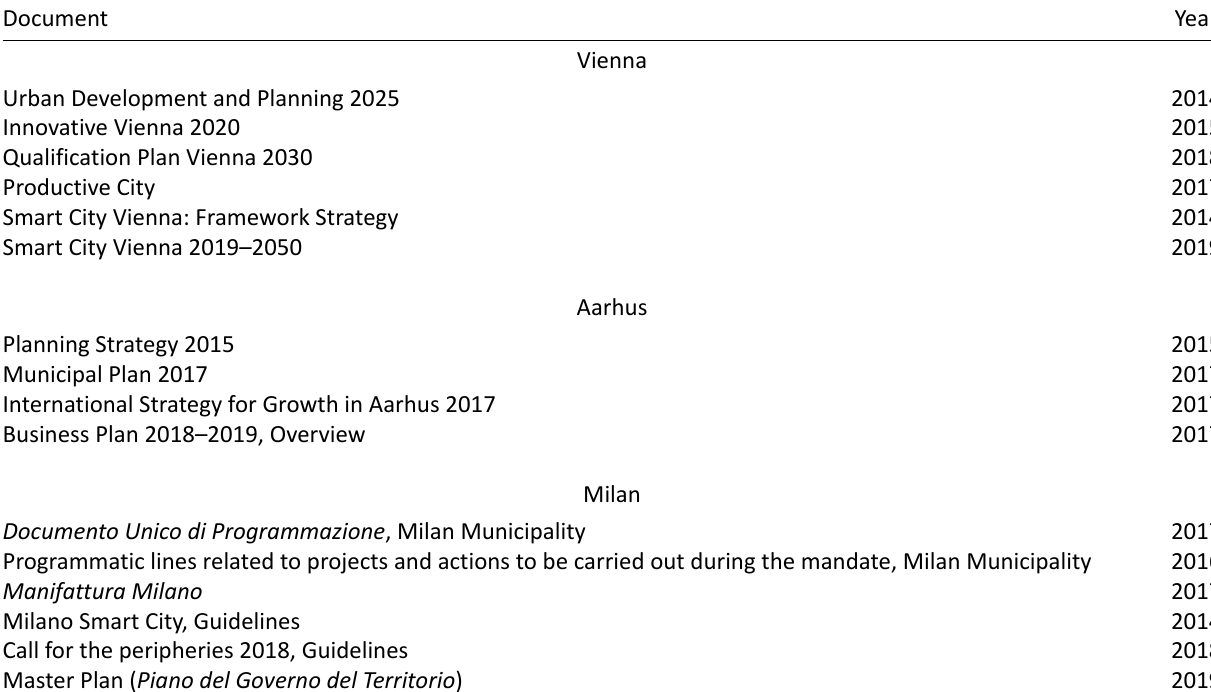
Table 2. Documents